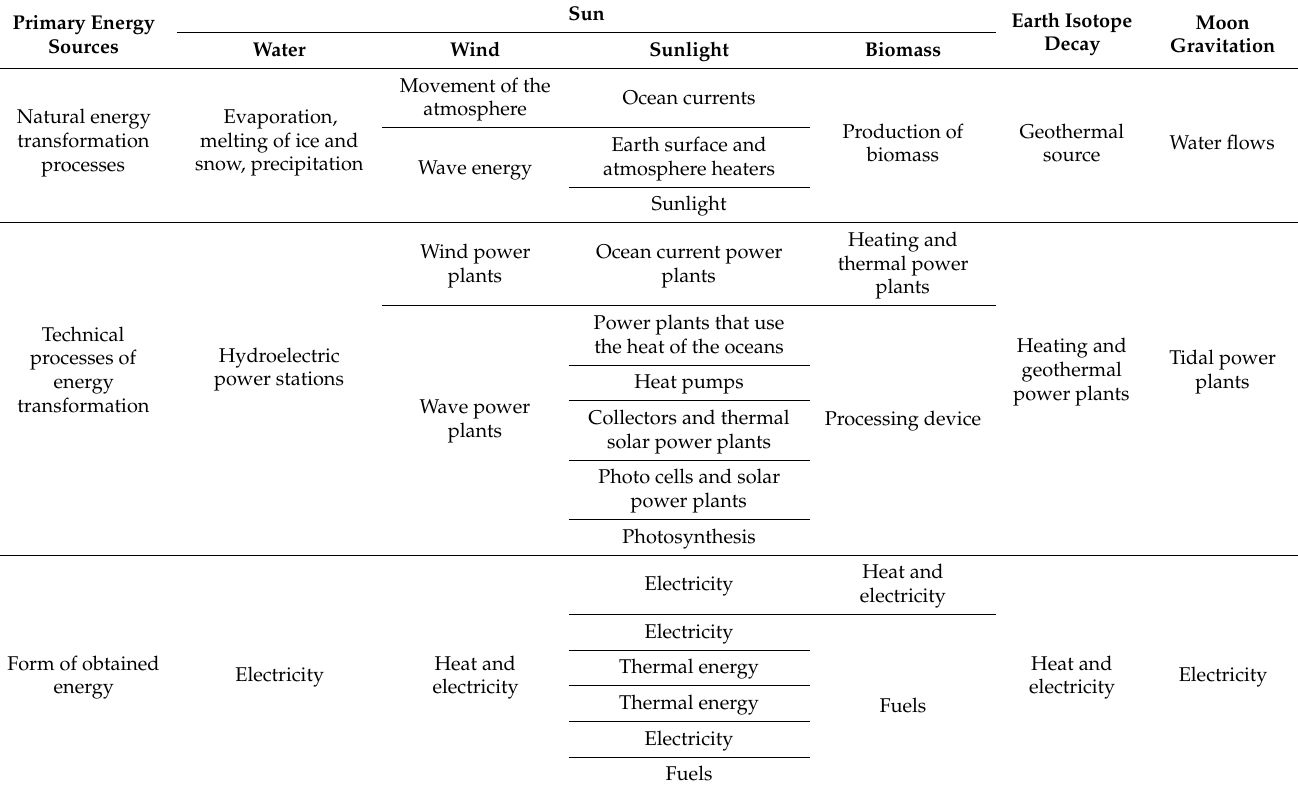
Table 1. Repartition of renovated energy